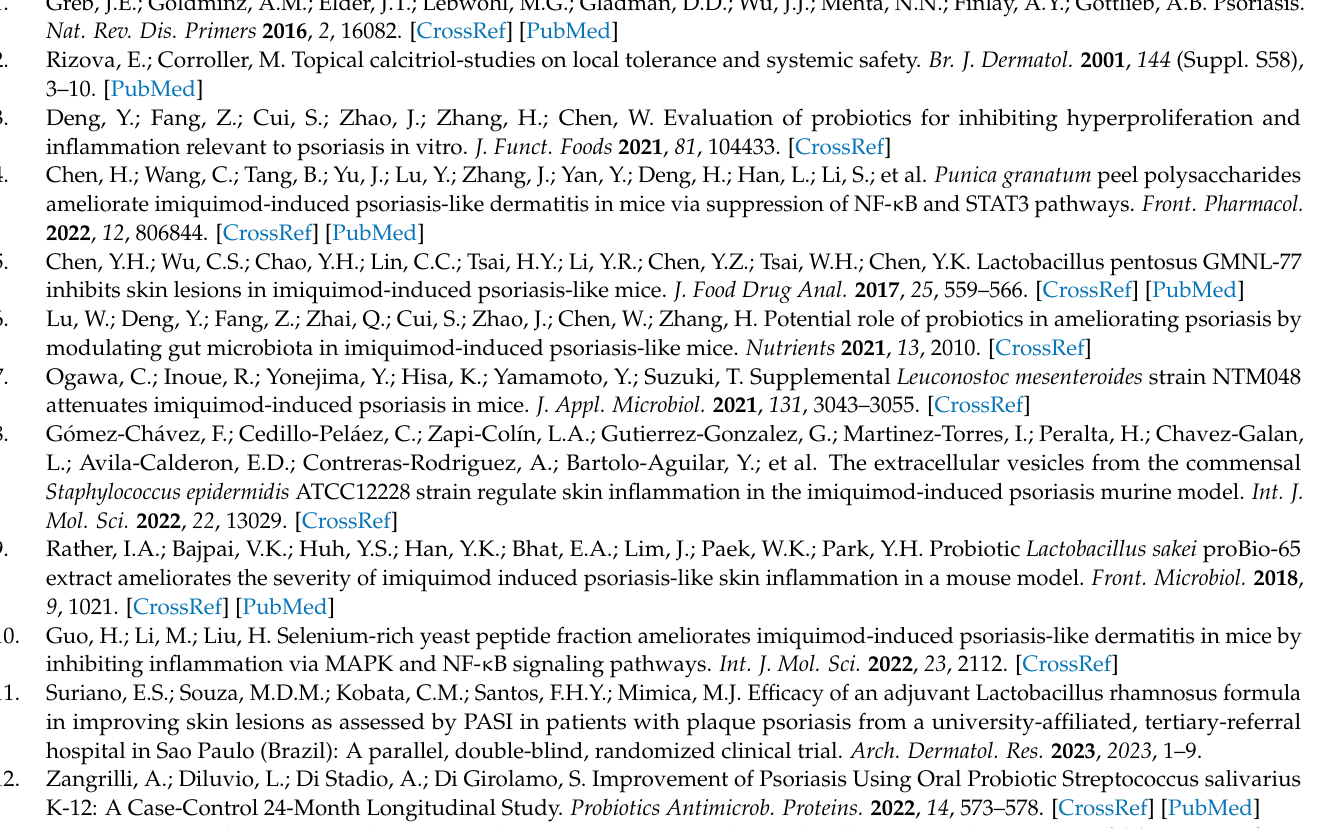
Figure S2: Quantitative relationships between the colonic LCA concentration and (a) ear thickness, (b) PASI and (c) histological score; Figure S3: Zi-Pi plot showing the distribution of genera based on their topological roles in networks. Each symbol represented an OTU in the bacterial network. The threshold values of Zi and Pi for categorizing genus were 2.5 and 0.62, respectively. Author Contributions: Conceptualization, B.Y. and W.C.; methodology, X.C. and Y.C.; software,